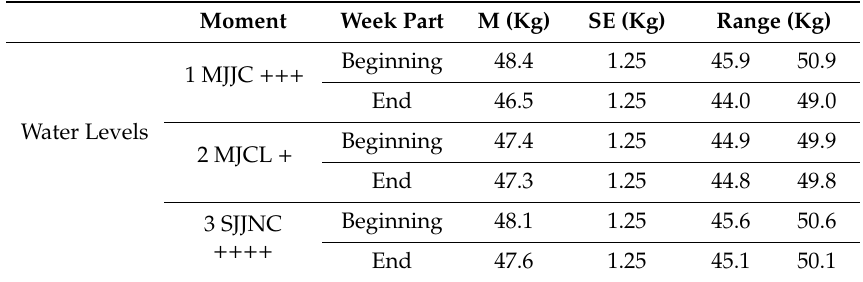
Table 6. Changes (mean M, standard error SE and range) among the di ff erent moments and comparing the week’s beginning and end in the water levels variable